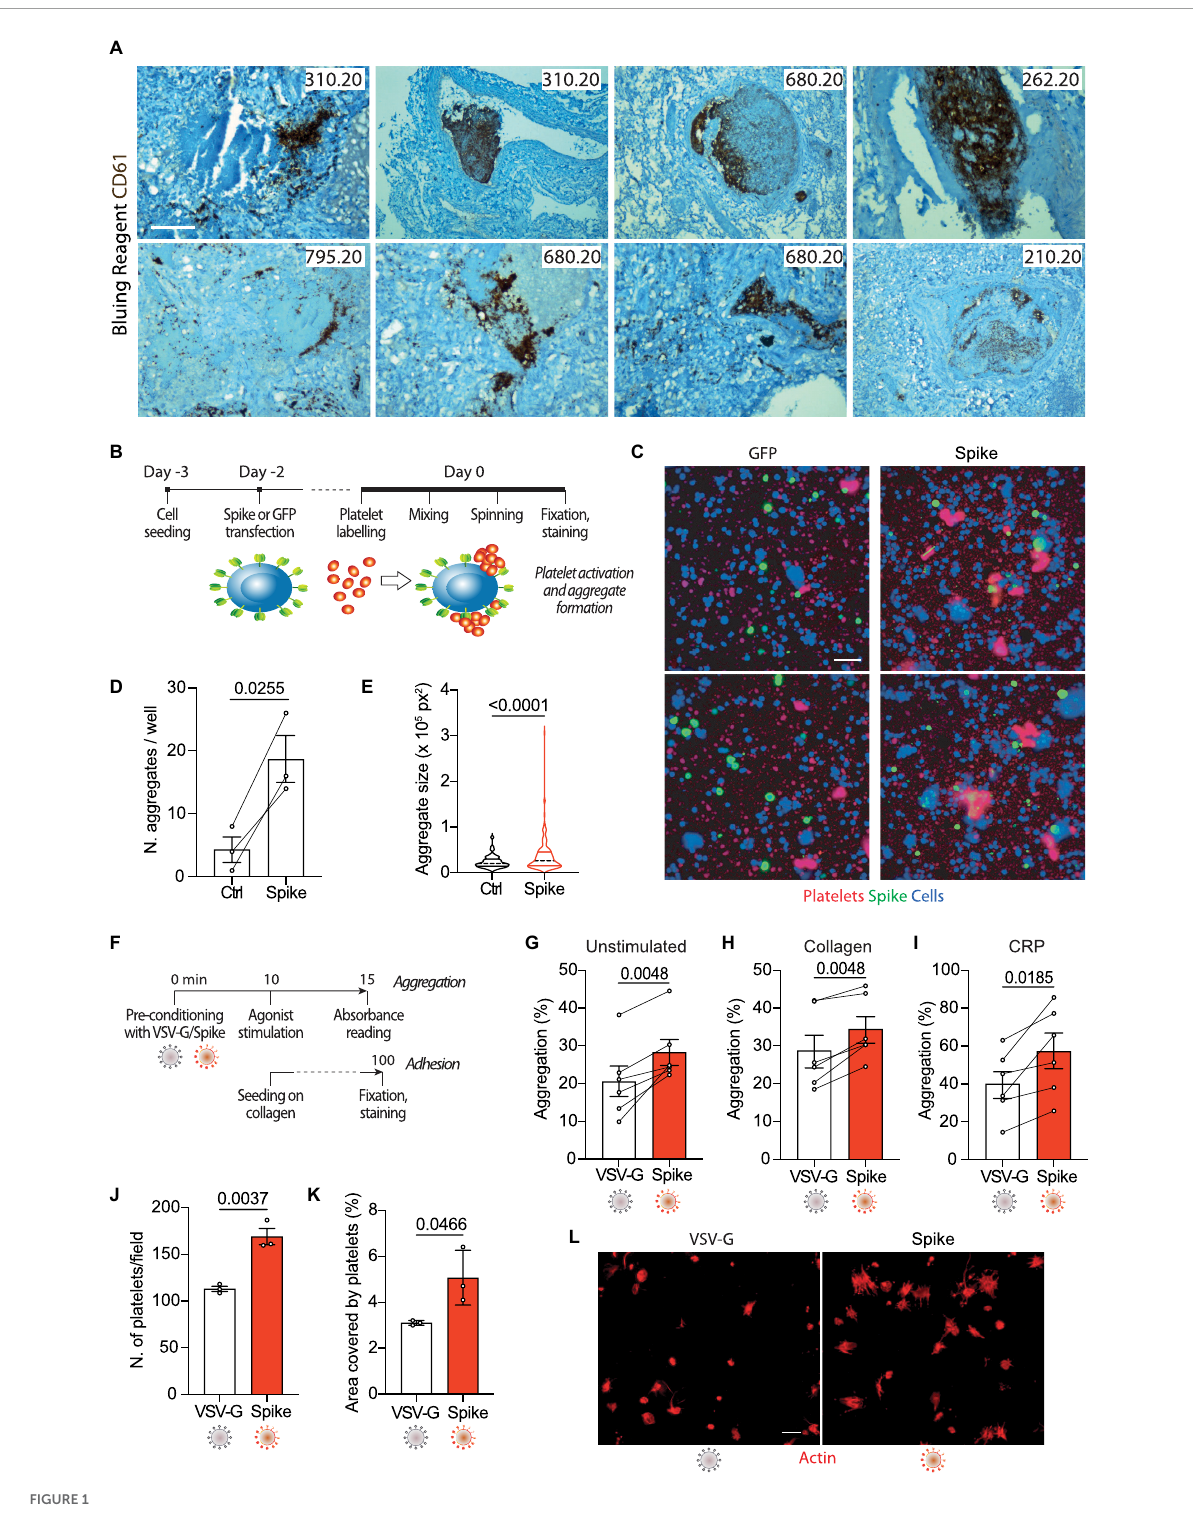
FIGURE1 Spike enhances platelet activation. (A) Histopathological evidence of platelet aggregates in the thrombotic microvasculature of SARS-COV-2-infected lungs from four COVID-19 patients. Numeric codes identify patients. Platelets were stained using an anti-CD61 glycoprotein antibody. Scale bar: 100 µ m. (B) Experimental scheme to study platelet activation and aggregate formation. Vero cells transfected to express either Green Fluorescent Protein (GFP) or SARS-CoV-2 Spike were incubated with pre-labeled washed platelets and shaken